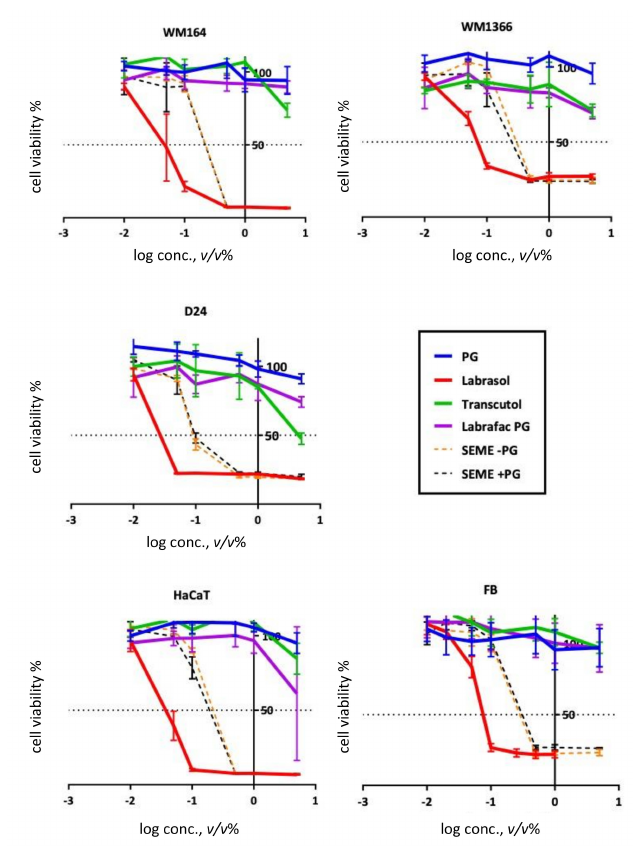
Figure 1. Toxicity assay. MTT assay after 1 h by MTT for di ff erent concentration of the excipients and